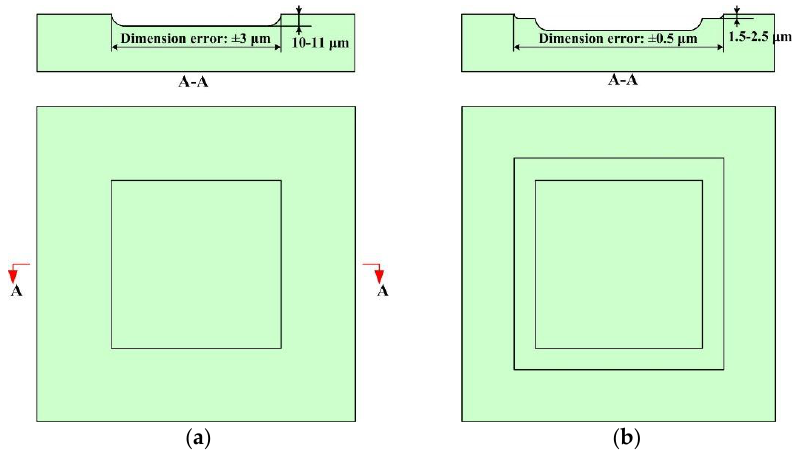
Figure A4. Fabrication process for stepped glass base: ( a ) 1st step for glass base etching; ( b ) 2nd step for glass etching.